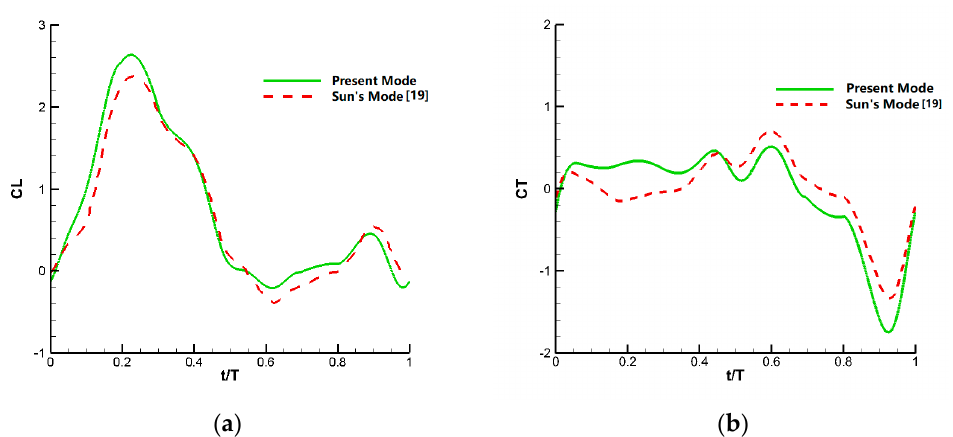
Figure 8. The comparison of the profiles of C L and C T in one hovering motion cycle. ( a ) The time history of C L; ( b ) the time history of C T.